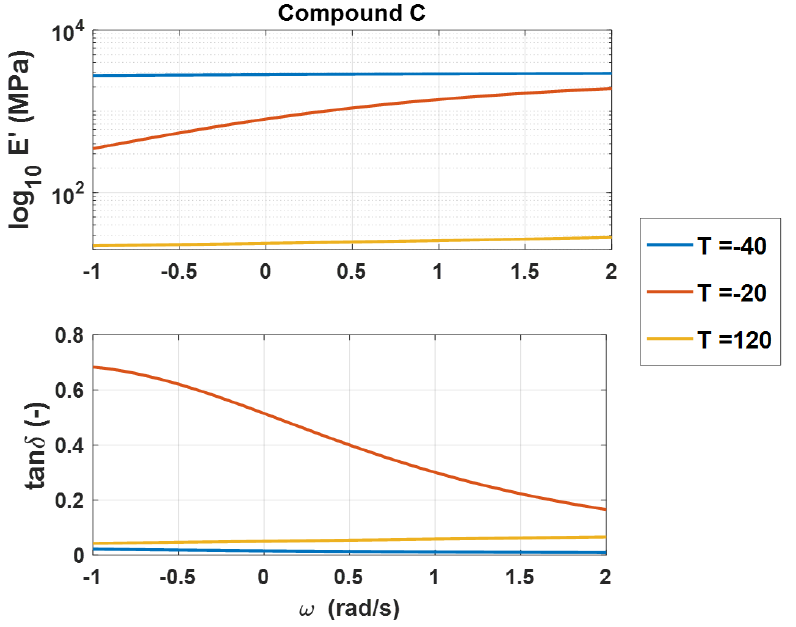
Figure 11. Example of the experimental starting set for the identification with partial DMA for compound C.